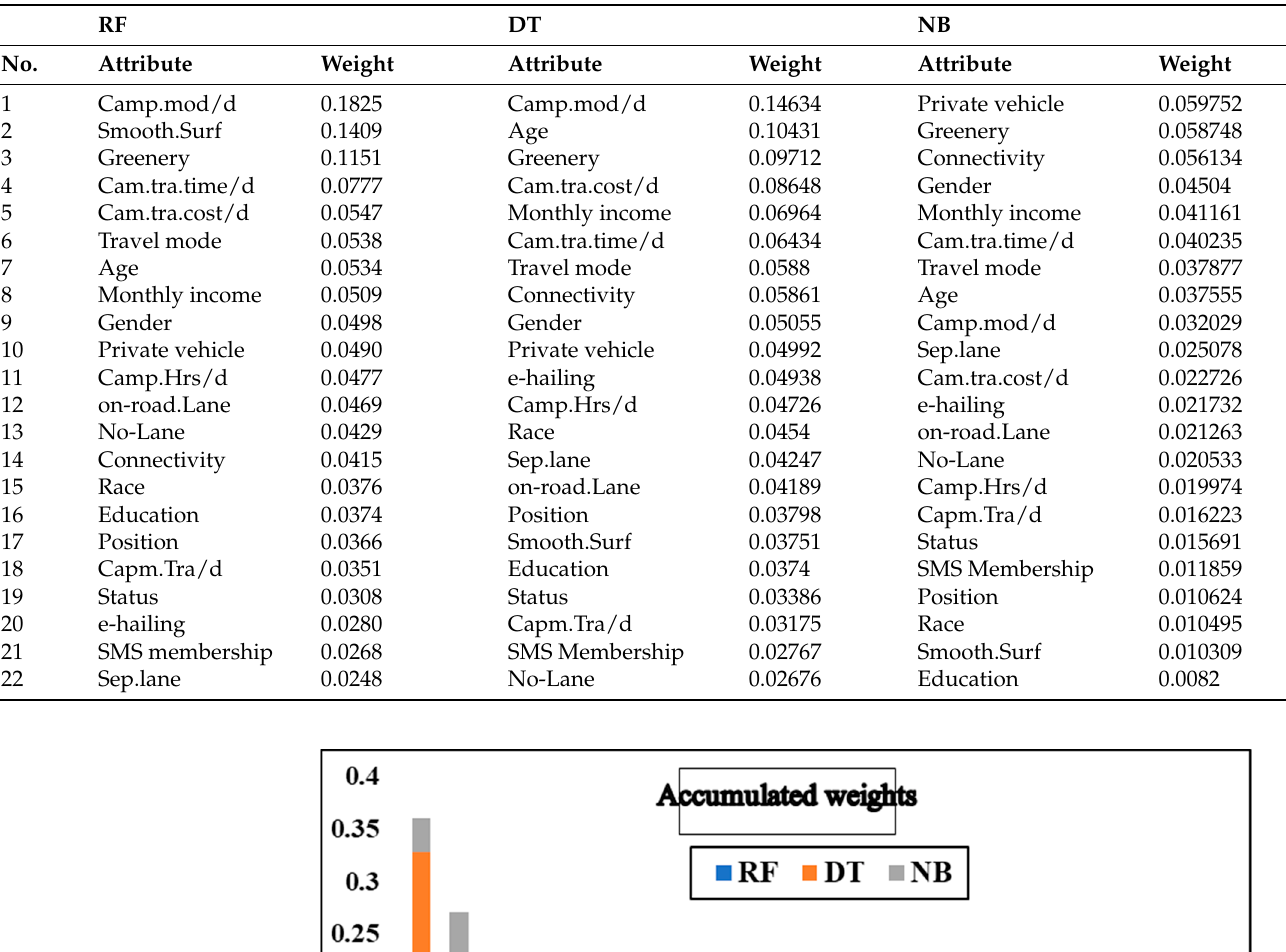
Table 3. Importance score (weight) of variables based on three ML methods.